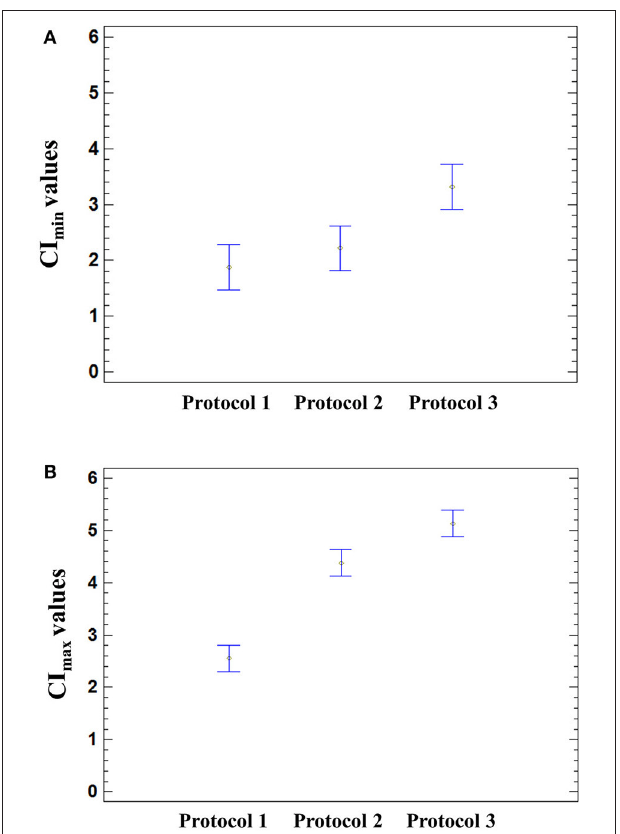
The result of the ANOVA is a p value associated with the hypothesis that the mean recovery rates of all groups were the